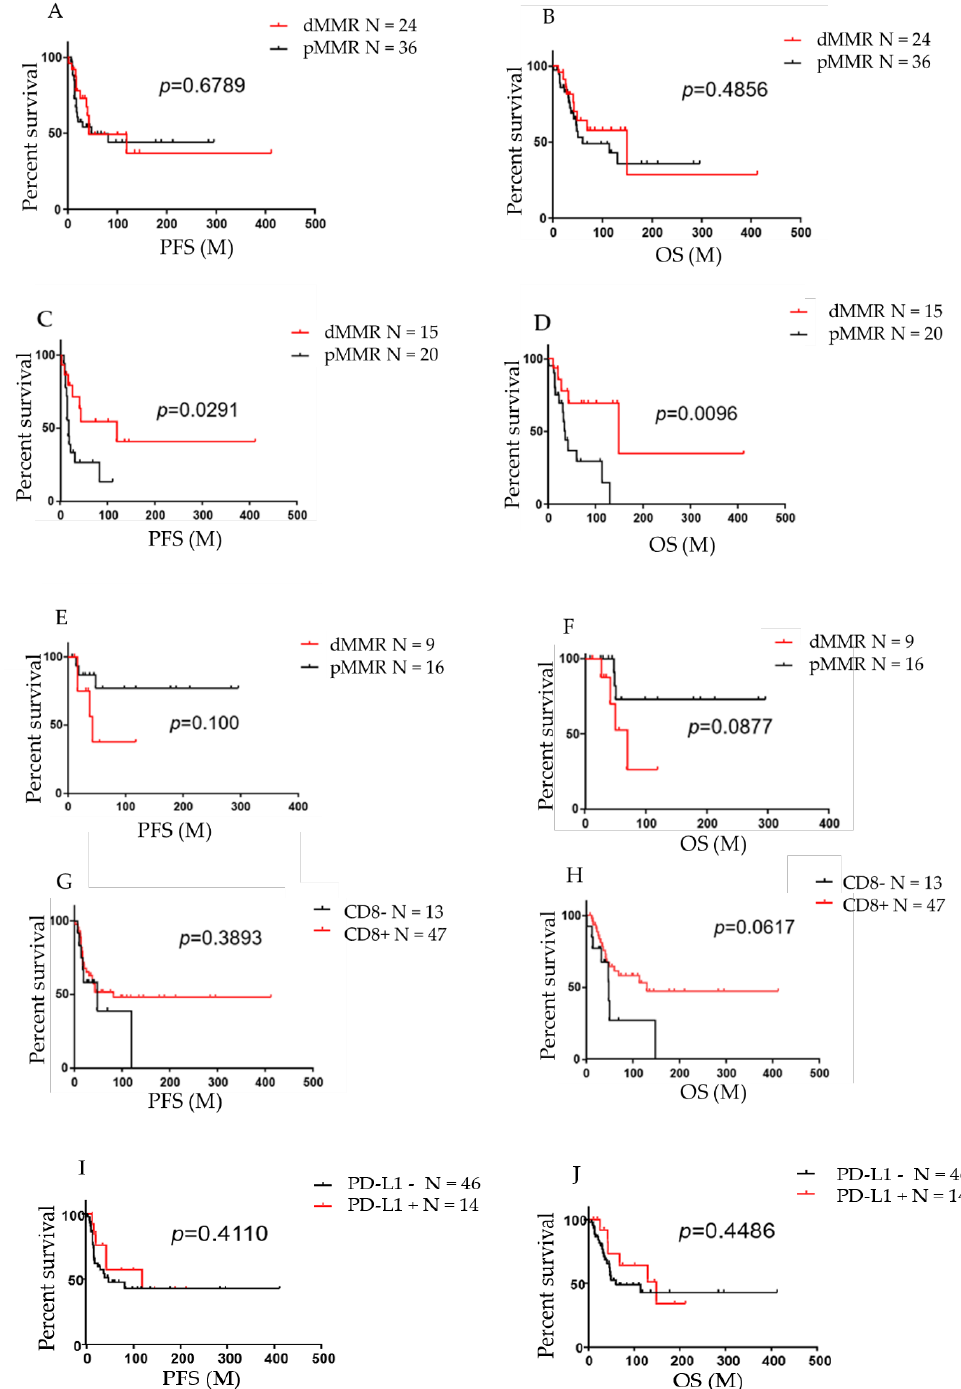
Figure 3. Prognostic analysis using Kaplan-Meier curves. ( A ) PFS (left panel) and ( B ) OS (right panel) analysis of type II EC patients between dMMR and pMMR group combining all stages together. ( C ) PFS (left panel) and ( D ) OS (right panel) analysis of type II EC patients between dMMR and pMMR groups for stage III/IV cases. ( E ) PFS (left panel) and ( F ) OS (right panel) analysis of type II EC patients between dMMR and pMMR groups for stage I/II cases. ( G ) PFS (left panel) and ( H ) OS (right panel) of type II EC patients with and without CD8 expression combining all stages together. ( I ) PFS (left panel) and ( J ) OS (right panel) of type II EC patients with and without PD-L1 expression combining all stages